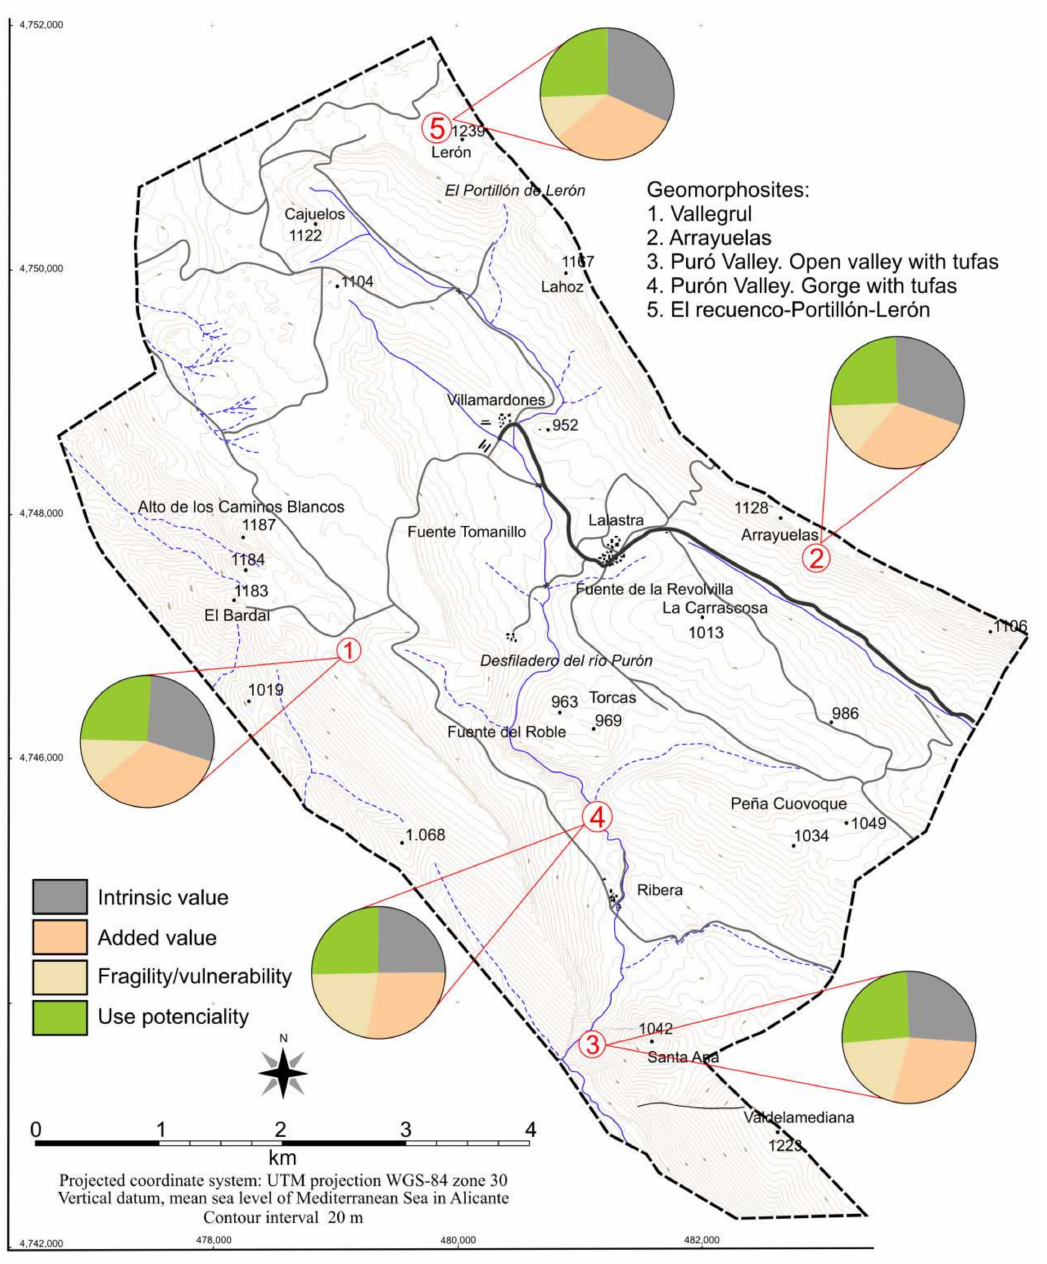
Figure 8. Inventory and valuation of geomorphosites in Valderejo Natural Park geomorpholical